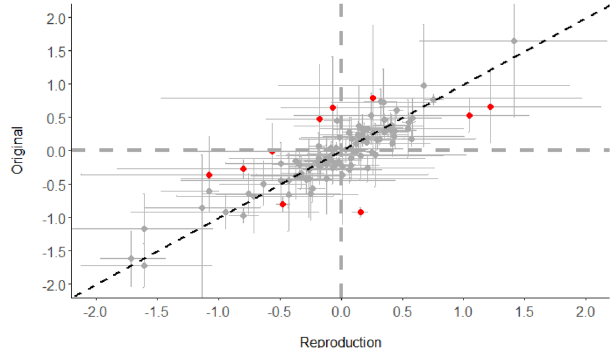
Fig.5|Calibrationplotofthelogarithmsofthehazardratio,riskratio,orodds ratio in the reproduction versus the original with correlation coef fi cient. Red points re fl ectthe10 most extreme outliersbased on difference betweenlog(effect size) for the original and reproduction. A summary of assumptions for these 10 outliers are in Supplementary Table 4. Error bars re fl ect the 95% con fi dence intervals for the original study and the reproduction. Horizontal and vertical dashed gray lines indicate where the original and reproduction effect sizes were null, respectively. The diagonal black dashed line re fl ects the perfect calibration line where original and reproduced effect sizes would be equal. Source data are provided as a Source Data fi le.